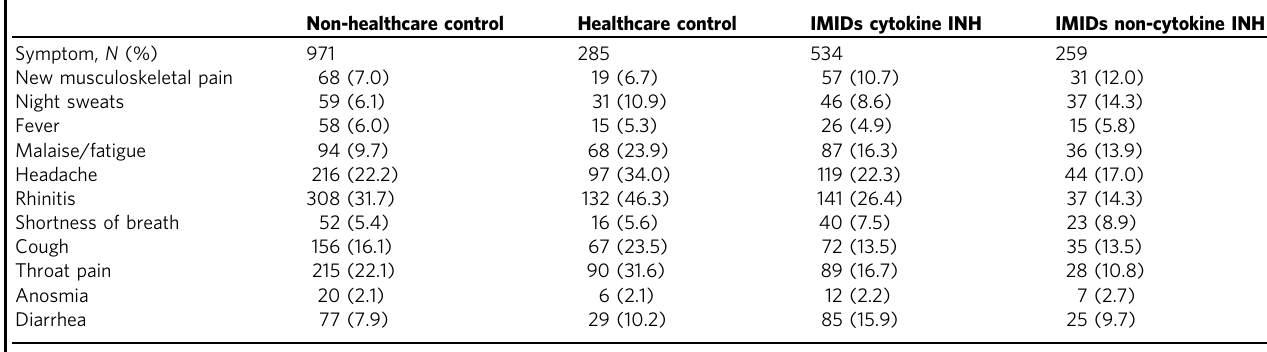
Table 3 Infectious symptoms.